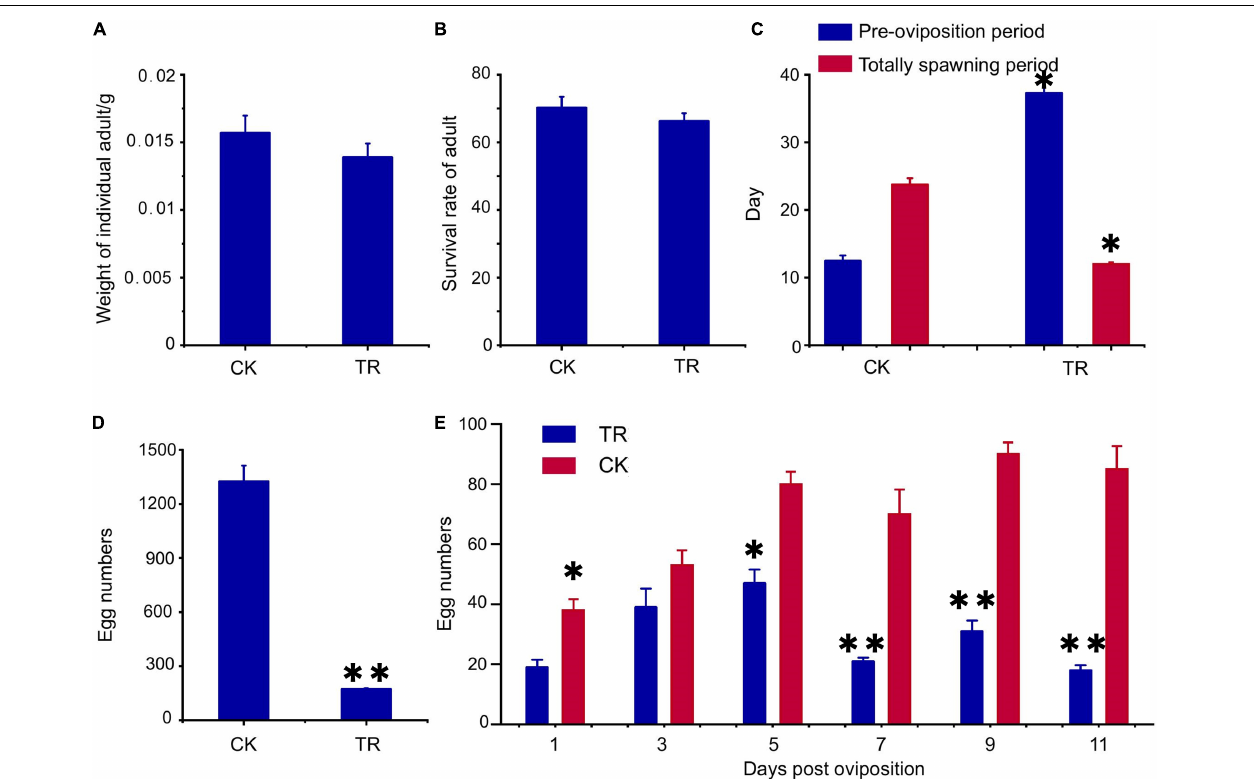
FIGURE 1 | Antibiotic feeding showed different effects on the growth and reproduction of Bactrocera dorsalis . (A) Antibiotic feeding did not decrease the weight of adults; (B) antibiotic feeding did not decrease the survival rate of adults; (C) antibiotic feeding prolonged the preoviposition period and shortened the total spawning period; (D) antibiotic feeding decreased the total number of eggs; (E) antibiotic feeding decreased the number of eggs per day after oviposition. CK, fruit flies reared under the normal conditions; TR, treatment group fed antibiotics. * p < 0.05; ** p <